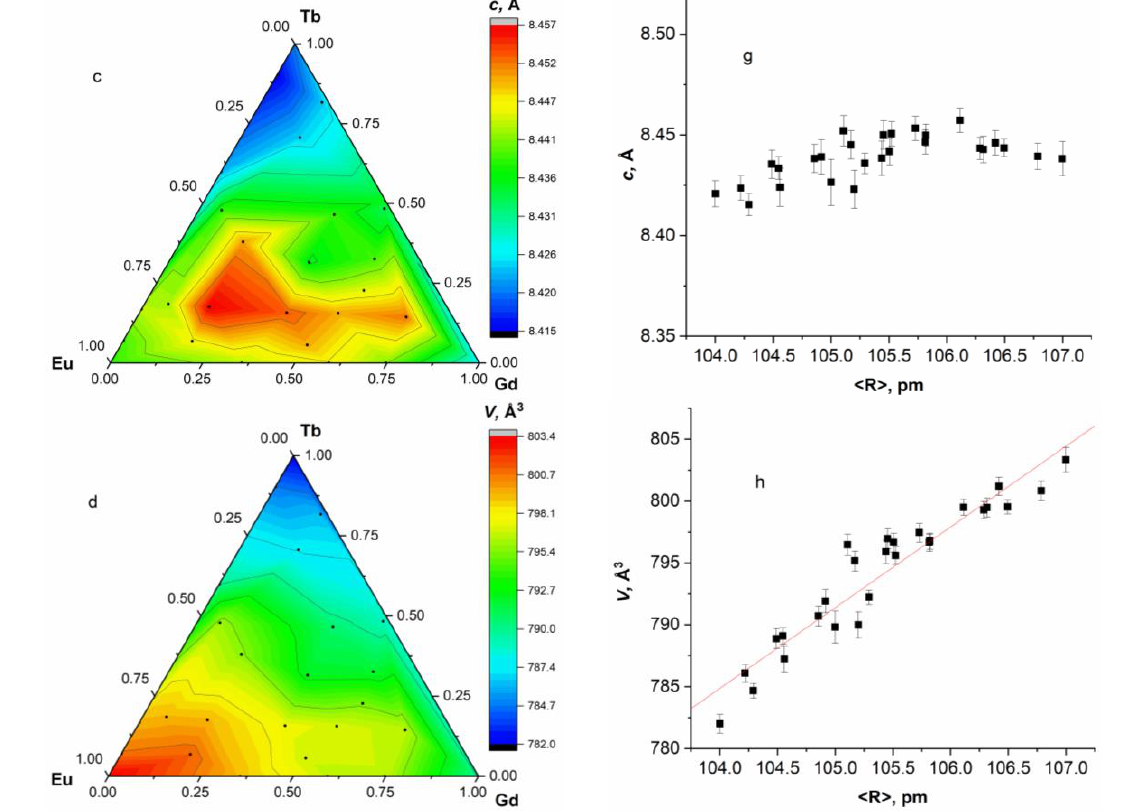
Figure 1. Ternary heat maps for parameters ( a ) a , ( b ) b , ( c ) c , and ( d ) unit cell volume of (Gd 1 − x − y Eu x Tb y ) 2 (OH) 5 Cl· n H 2 O. Each point on the ternary diagram corresponds to individual x and y values, which determine the cationic composition of (Gd 1 − x − y Eu x Tb y ) 2 (OH) 5 Cl· n H 2 O. Dependences of the parameters ( e ) a , ( f ) b , ( g ) c , and ( h ) unit cell volume of (Gd 1 − x − y Eu x Tb y ) 2 (OH) 5 Cl· n H 2 O on the average radius of the lanthanide cation (the sum of the radii of gadolinium, europium and terbium, normalised to their respective contents in LRH).